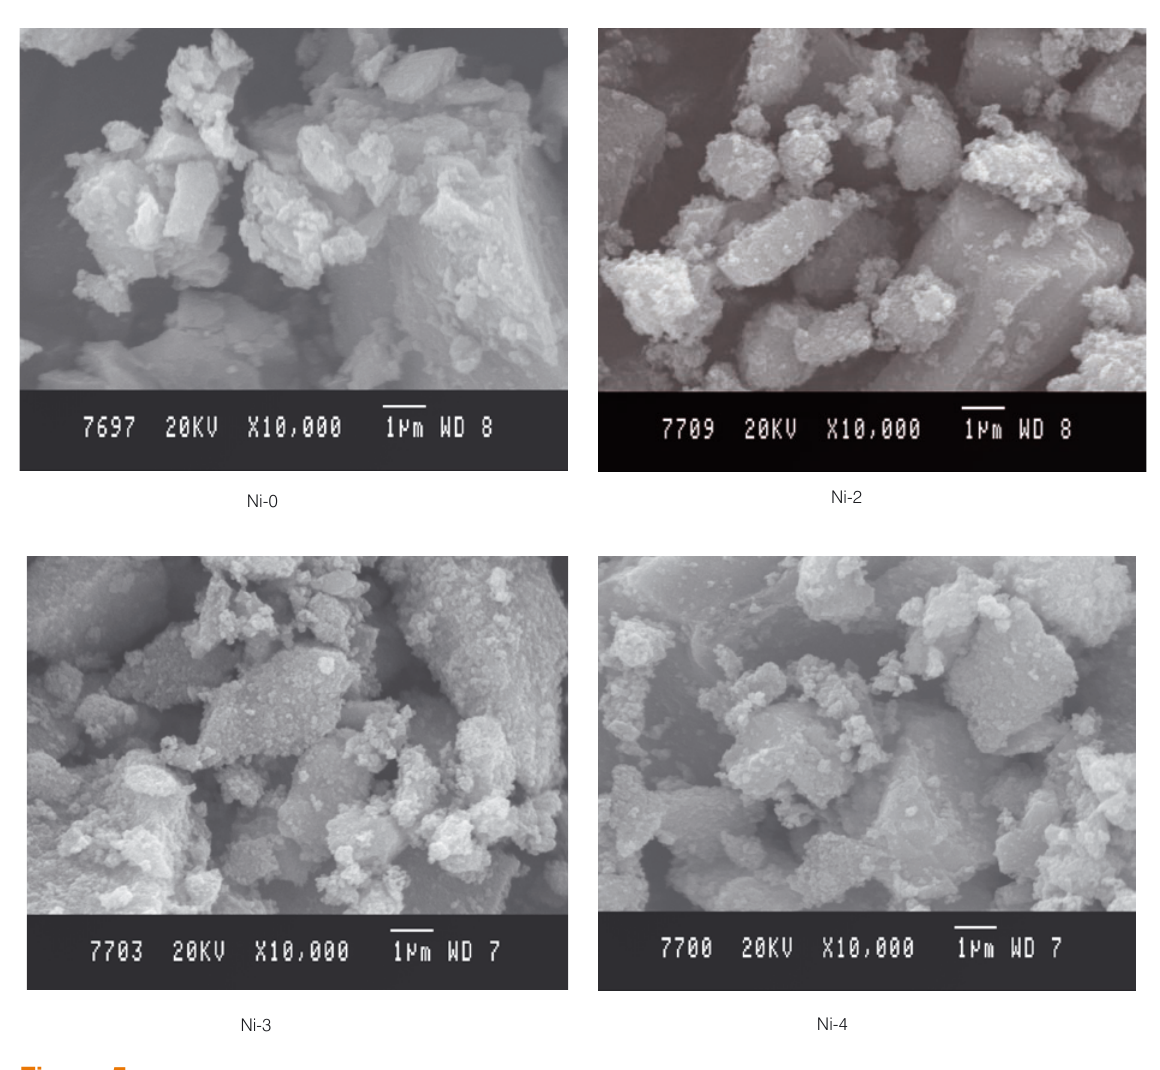
Figure 5. SEM images of